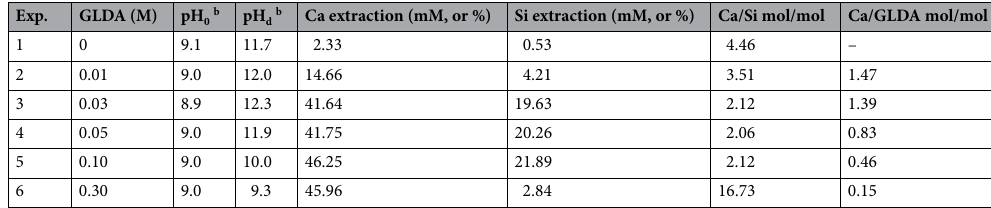
Table 1. Conditions of the calcium silicate-GLDA reaction and fluid chemistries obtained after 20-min extraction. a a All experiments were conducted with 0.1 M Ca silicate at 50 °C. Each experiment was repeated twice and the average values were shown, the experiments showed good reproducibility within a margin of error of 3%. b “pH 0 ” refers to the initial pH, and “pH d ” refers to the pH after dissolution. Both pH values were measured at room temperature.